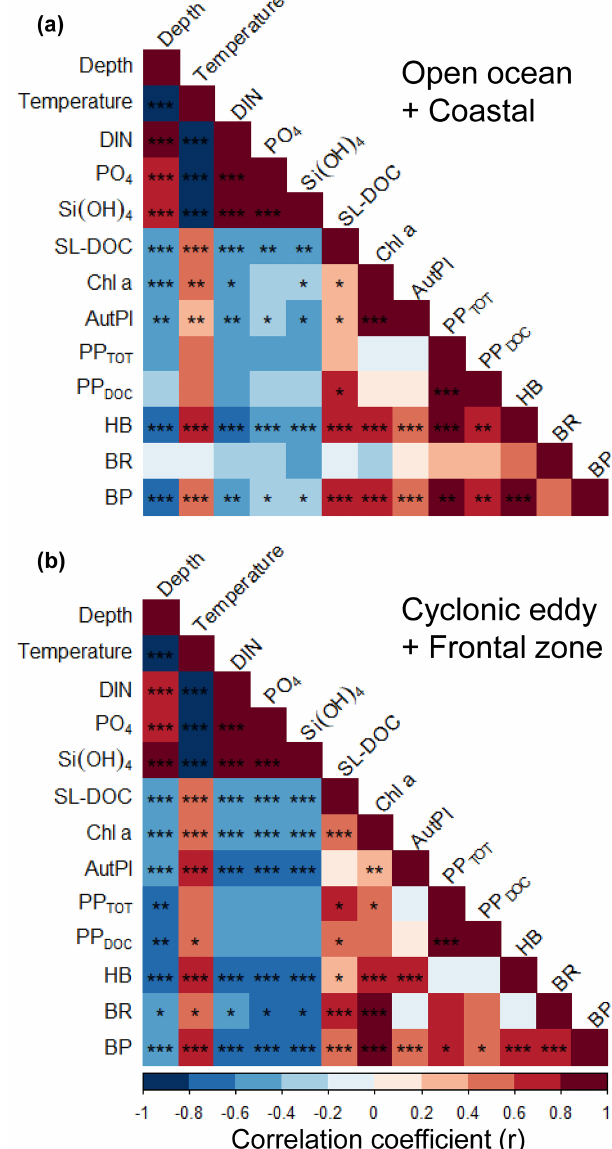
Figure 7. Pearson correlation matrix of biochemical parameters, metabolic activities, and bacterial abundance in the upper 100m in samples not influenced by the cyclonic eddy (i.e. coastal and open ocean stations) (a) and samples influenced by the cyclonic eddy (b) . Statistical significance: ∗∗∗ < 0 . 001, ∗∗ < 0 . 01, ∗ < 0 .